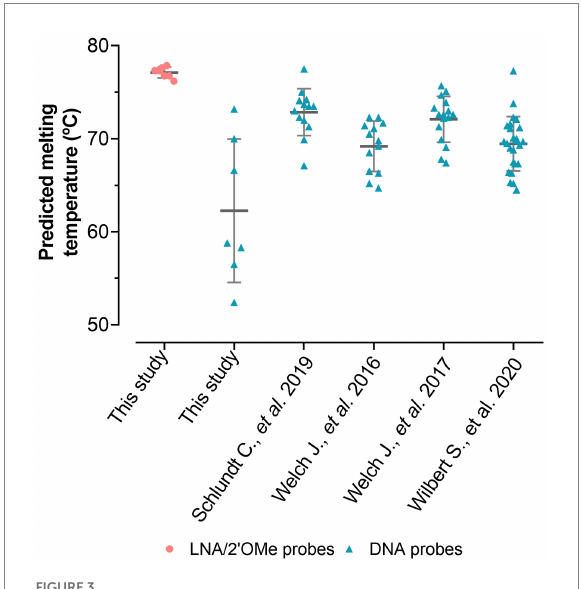
FIGURE 3 Comparison between predicted melting temperatures of the LNA probes used in this study and DNA probes already published (16–19). The DNA probes of this study have the exact same sequences of the LNA probes but were only used for the predicted melting temperature assessment. Predicted melting temperatures were calculated according to Fontenete et al. (2016a).